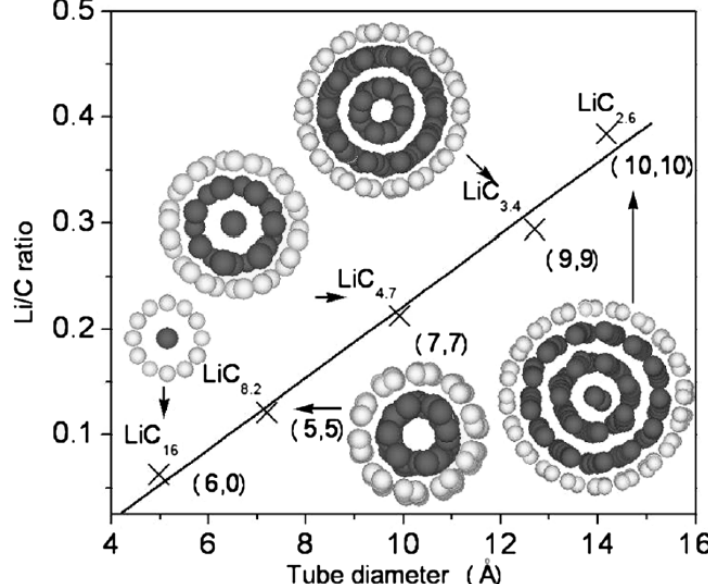
Figure 4. The variation of Li / C ratio as a function of tube diameter. The equilibrium configurations SWNTs filled with Li atoms are shown in the insets of this figure. White and grey balls represent carbon and Li atoms, respectively. (Reprinted with permission from [13]. Copyright (2005) by Elsevier).